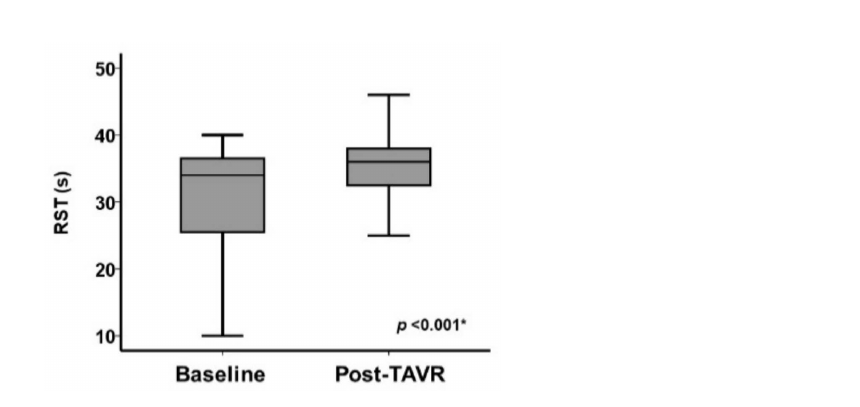
Figure 4. Change in RST following TAVR. * p < 0.05 using the Wilcoxon signed-rank